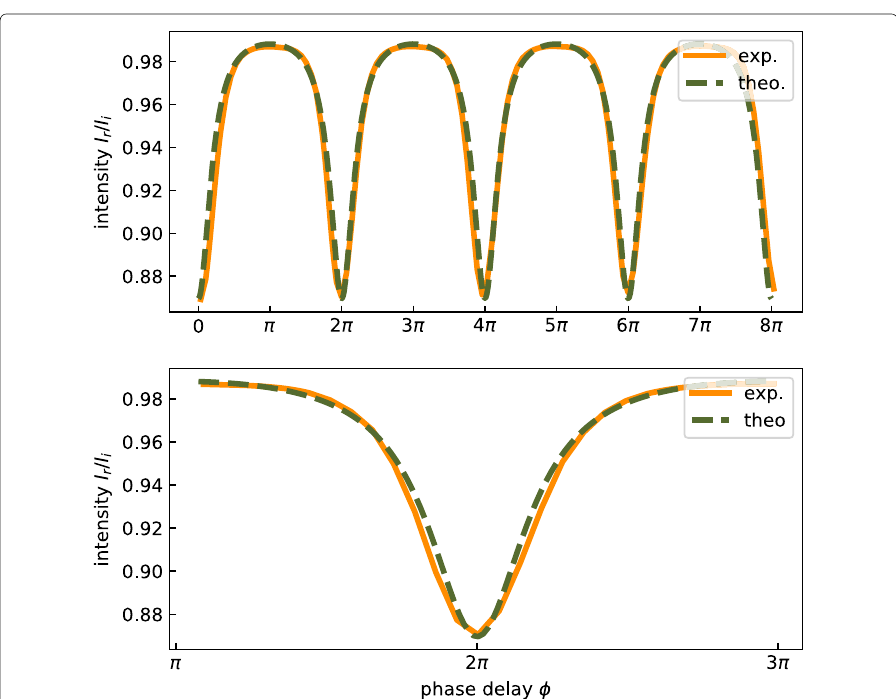
Fig. 3 Theoretical and experimental transfer function of the reflective mode of the Fabry-Perot interferometer. Top shows the measured and theoretical interference response of the cavity as a function of increasing phase delay (i.e. increasing fiber-cantilever separation). This fiber end has a 30% back reflection. Bottom shows the first full interference peak that occurs as peak intensity as a function of phase delay. The experimental data is plotted with the theoretical fit